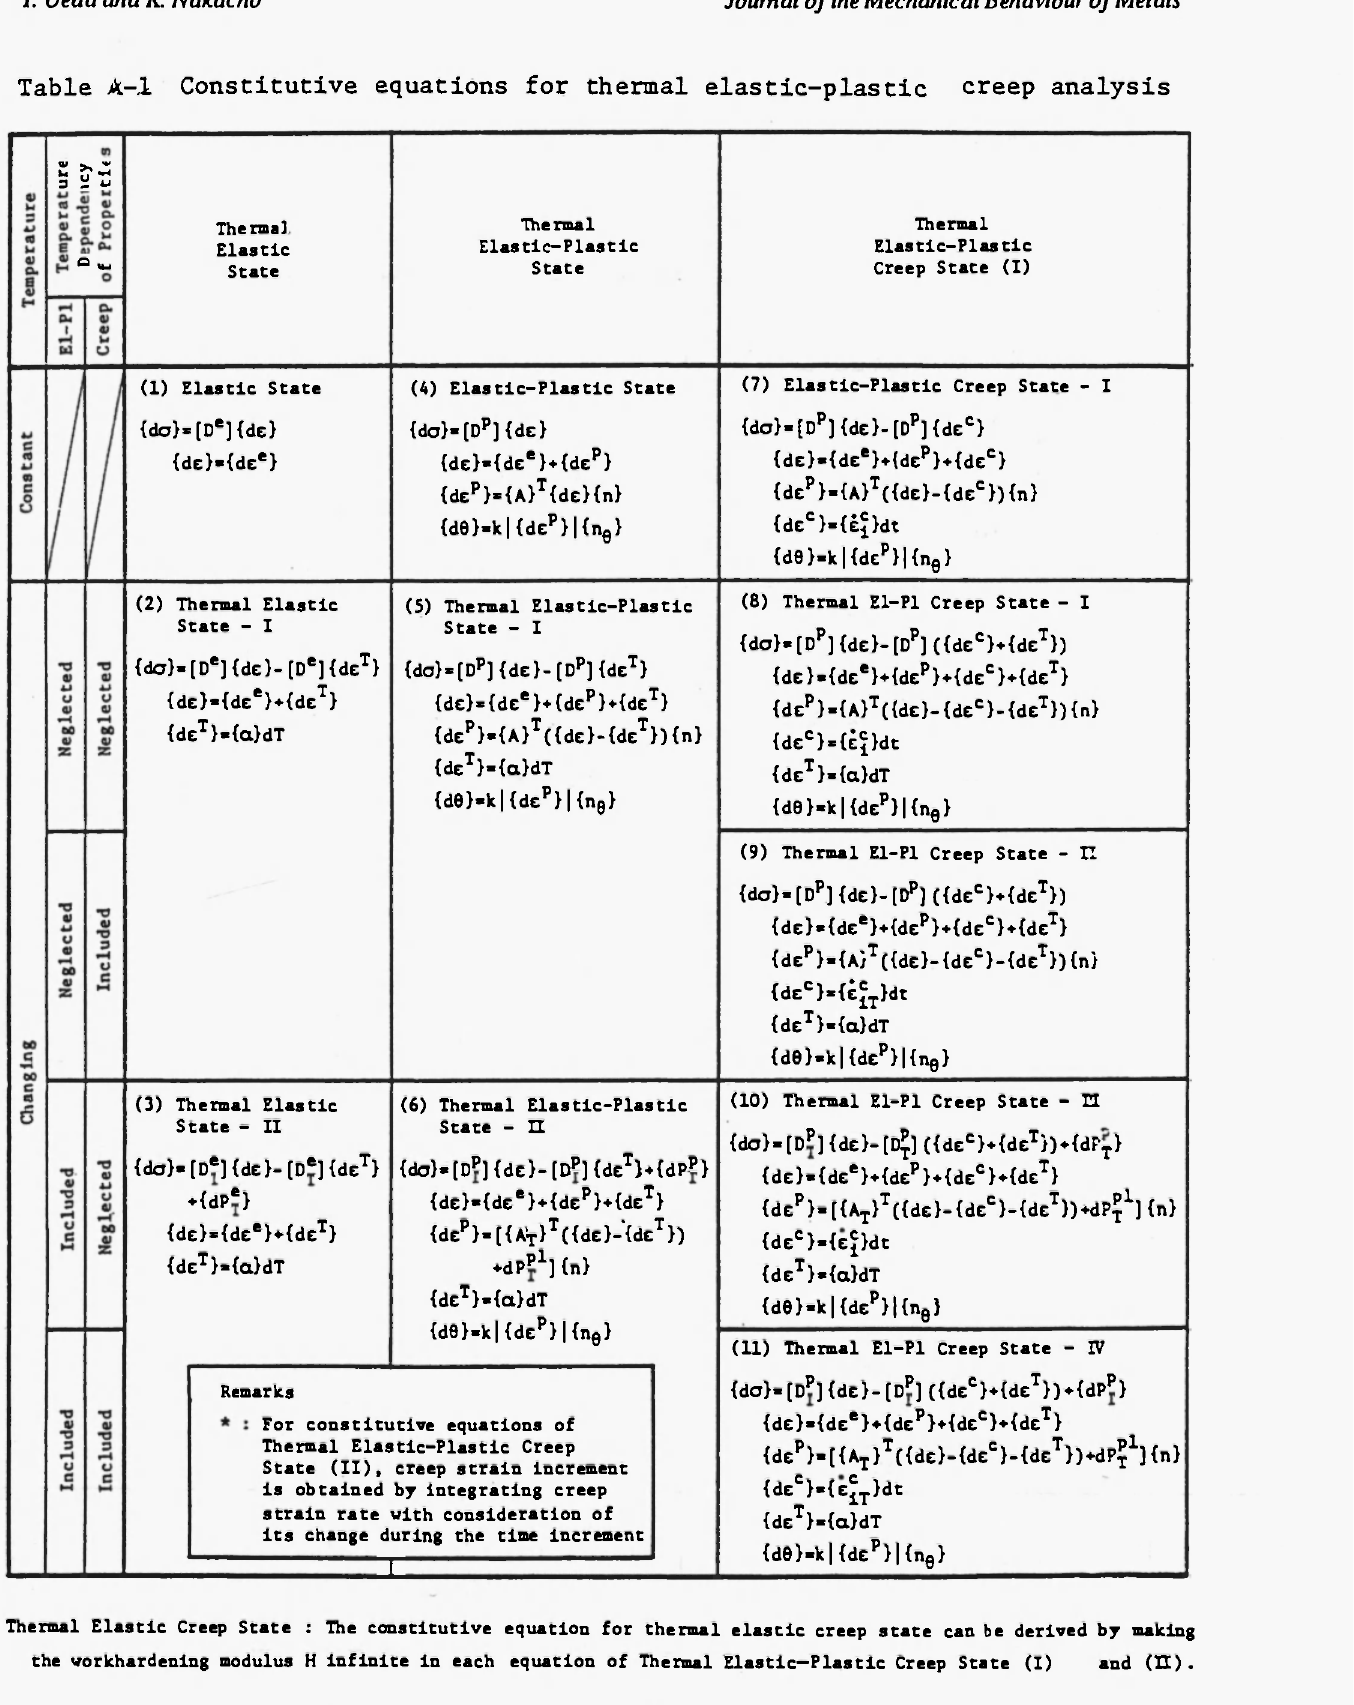
Constitutive equations for thermal elastic-plastic creep